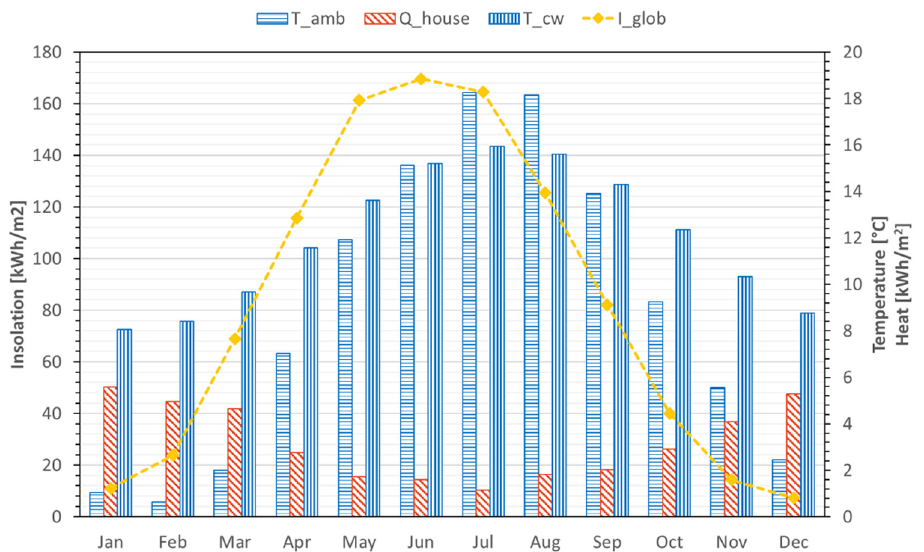
Figure 5. Climate data—graph showing monthly global insolation (I_glob), ambient temperature (T_amb), cold water inlet supply temperature (T_cw), along with monthly specific heat demand (SH + DHW) for a single-family house (Q_house), in Kungsbacka, Sweden [12].